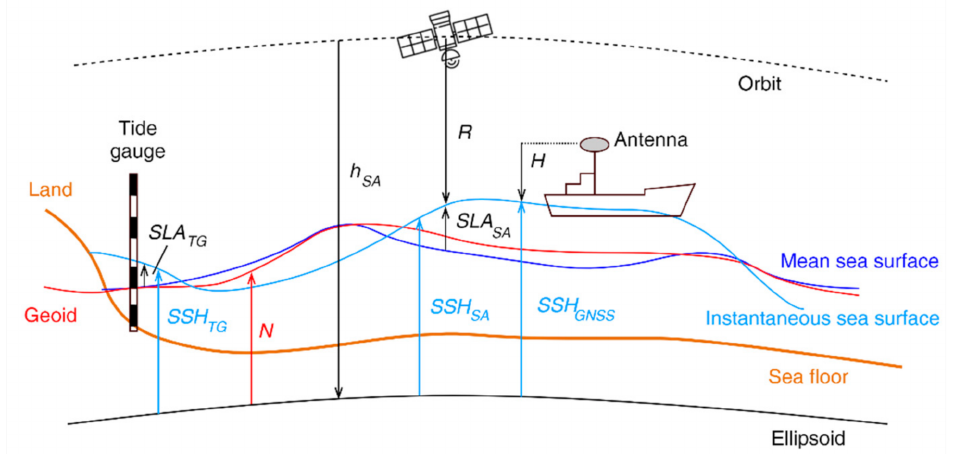
Figure3. Schematicplotoftherelationshipbetweentheseasurfaceheightmeasuredbysatellitealtimetry ( SA ), tide gauge ( TG ) and GNSS on the vessel ( GNSS ). Abbreviations meaning: SSH —instantaneous sea surface height, SLA —instantaneous sea-level anomaly, h —ellipsoidal height, N —geoid